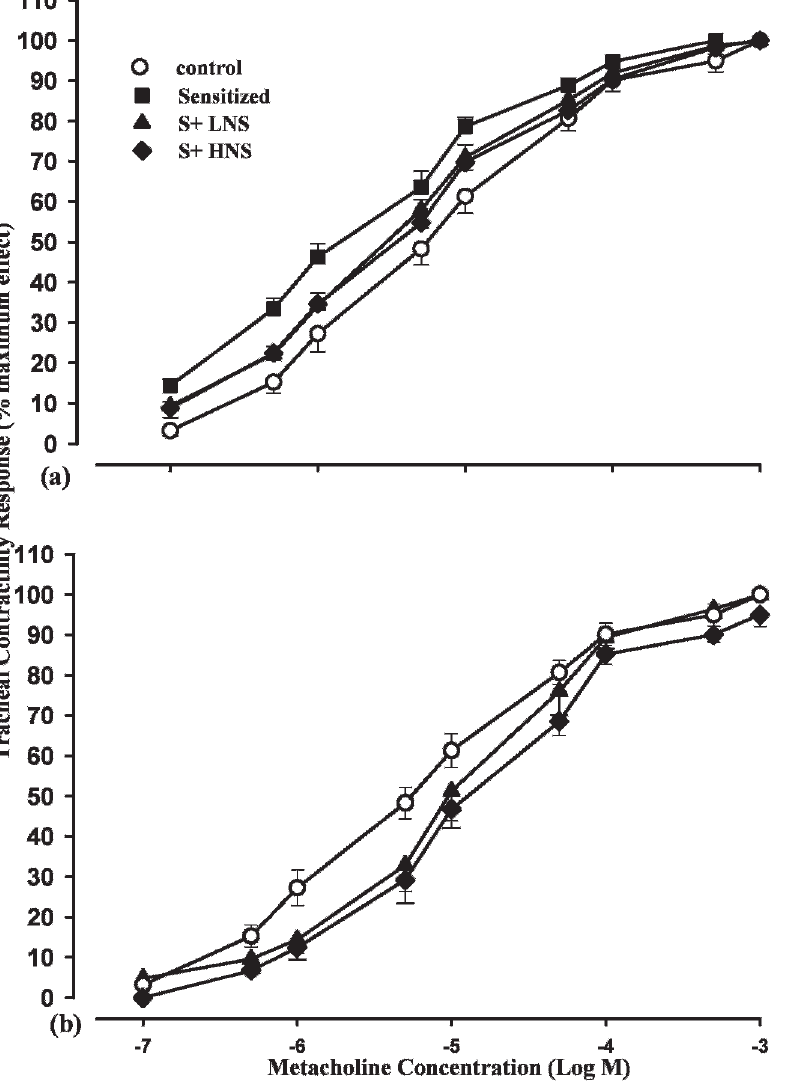
Figure 2 - Cumulative log concentration-response curves of methacholine-induced contraction of trachea isolated from control (C), sensitized (S), S treated with low dose of N. sativa extract (S + LNS) and S treated with high dose of N. sativa extract (S + HNS) guinea pigs in the absence (a) or presence of 0.25 g% N. sativa extract for 7 mins (b; for each group,